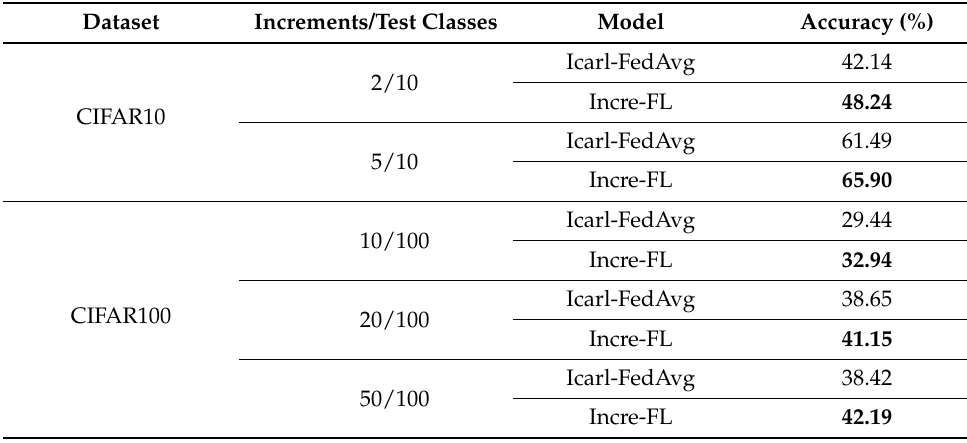
Table 5. The influence of the dual attention mechanism module.